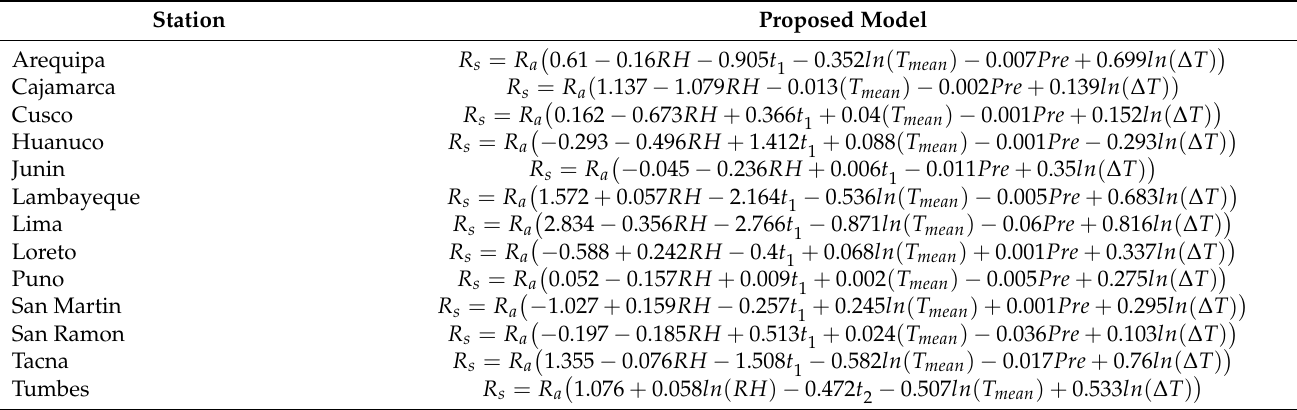
Table 6. New models proposed for estimating solar radiation in each